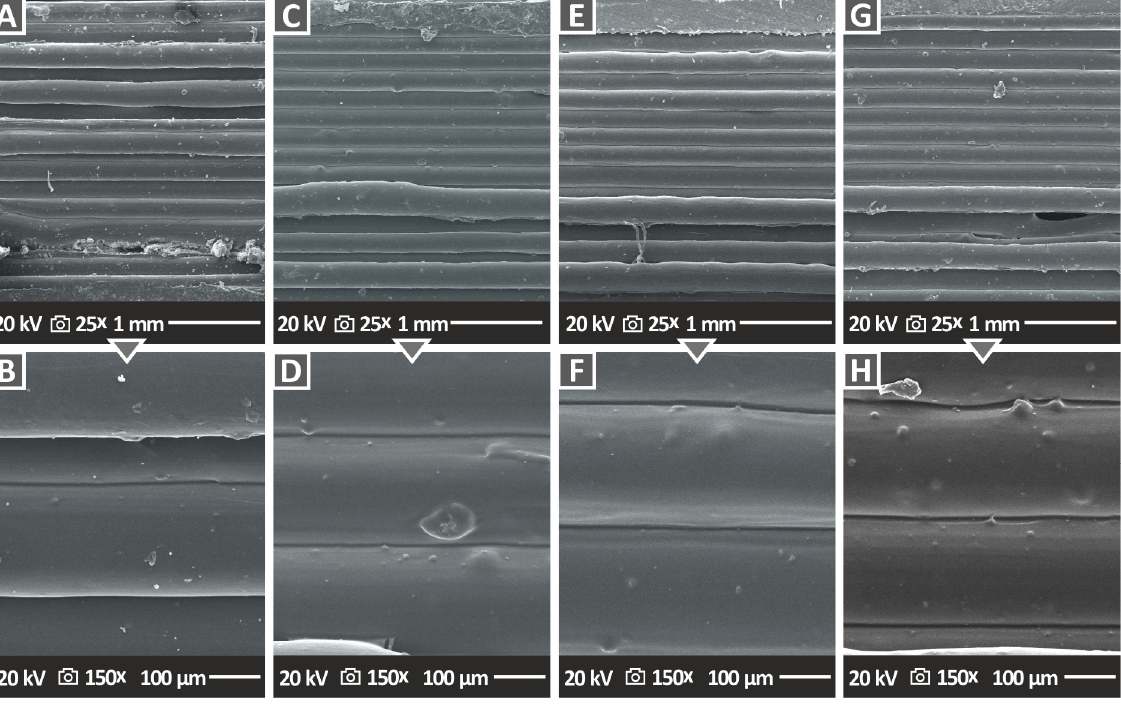
Figure 11. SEM images of the side surface morphology of ( A , B ) PLA/Al 2 O 3 (1.0 wt.%), ( C , D ) PLA/Al 2 O 3 (2.0 wt.%), ( E , F ) PLA/Al 2 O 3 (3.0 wt.%), and ( G , H ) PLA/Al 2 O 3 (4.0